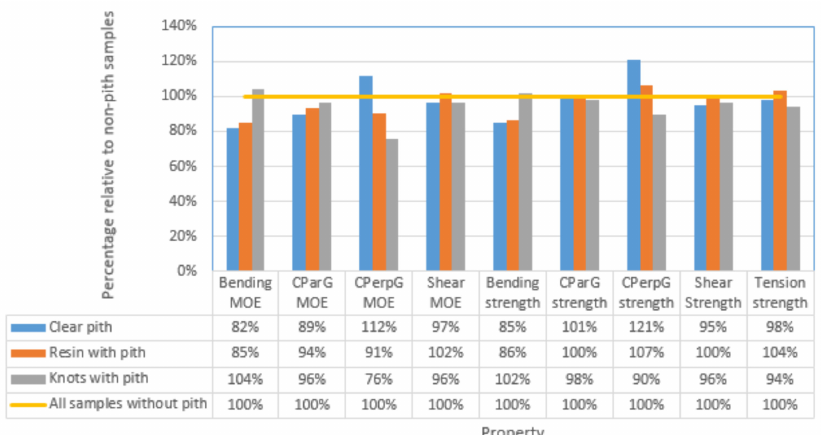
Figure 34. Summary of pith sample structural performance relative to non-pith